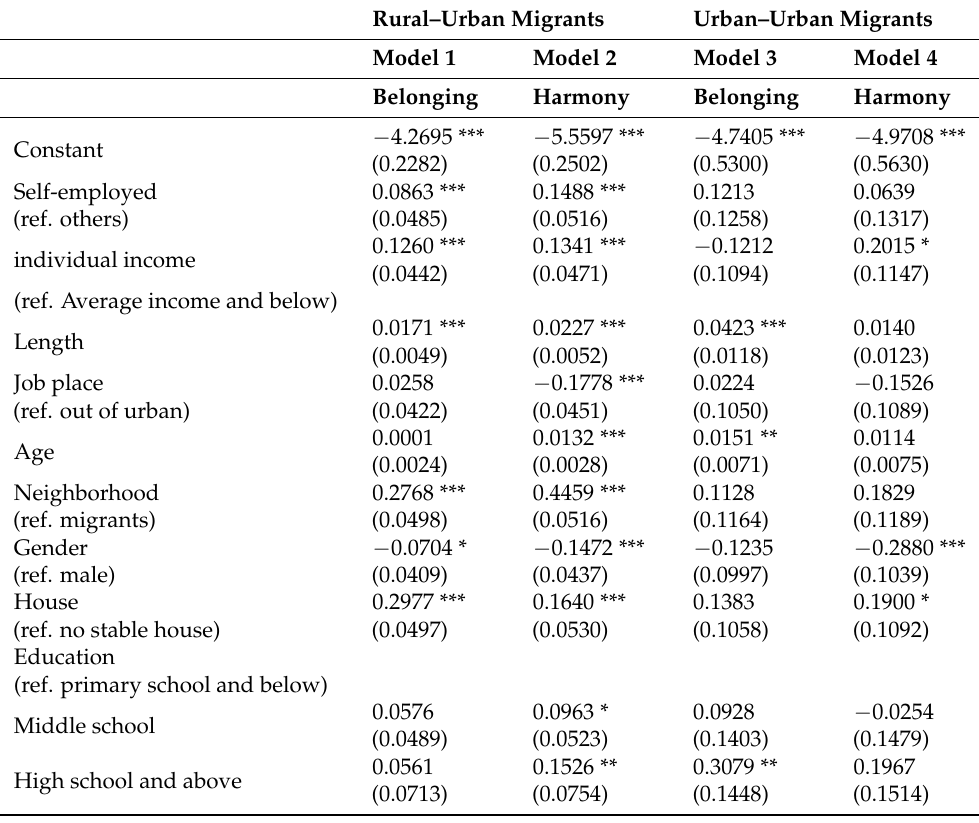
Table 3. Logistic regression results on rural–urban and urban–urban